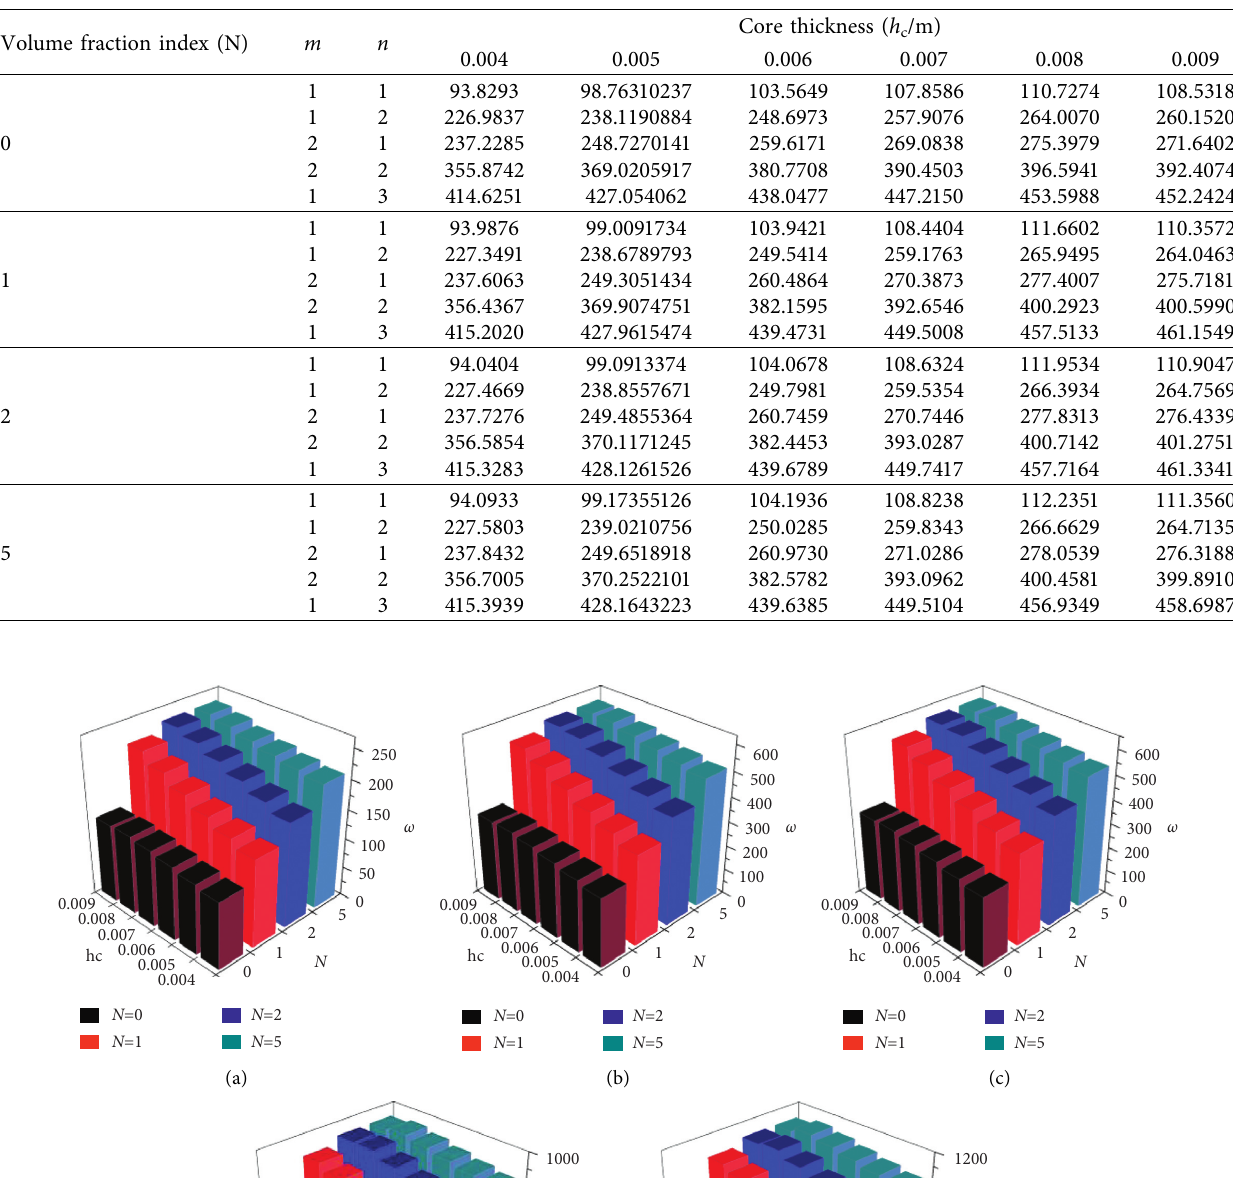
Table 4: Type B: the first five natural frequencies ω of the simply supported FGH sandwich plate.